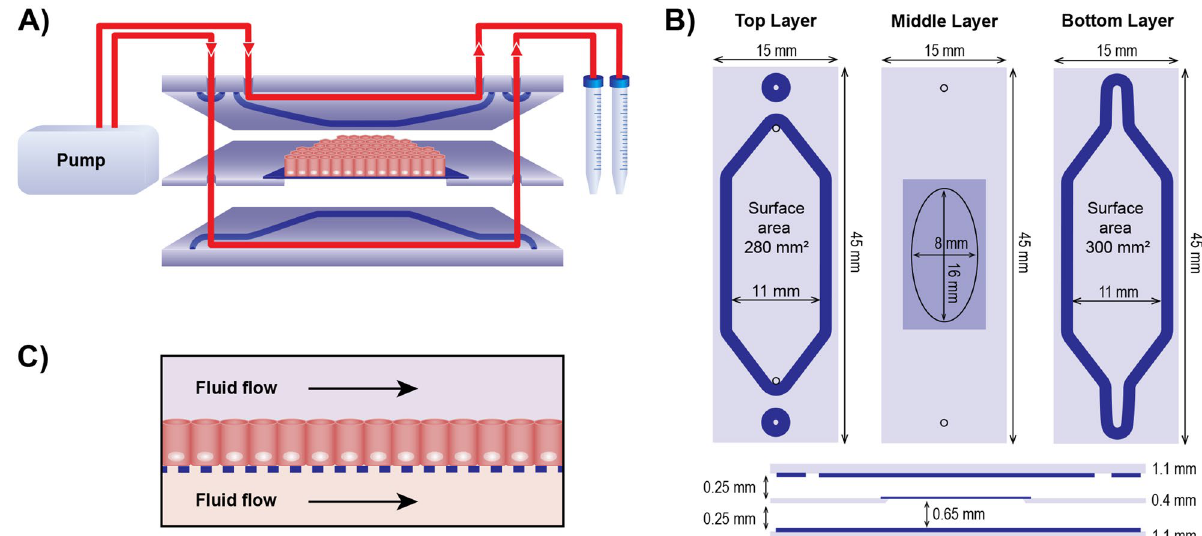
Figure 1. Schematic illustration of the experimental setup of the gut-on-chip ( A ) Schematic design of the microfluidic system showing a vertical cross-section of the glass chip. The red lines represent the flows in and out of both compartments. ( B ) Schematic drawing of the three glass layers that form the chip, the oval in the middle layer represents a cut-out in the glass and the darker square represents the porous membrane covering the cut-out. The dark blue lines in ( A ) and ( B ) represent the gaskets that form the boundaries of the compartments when the three glass layers are pressed together in the chip holder. ( C ) Schematic drawing showing how cells were exposed to fluid